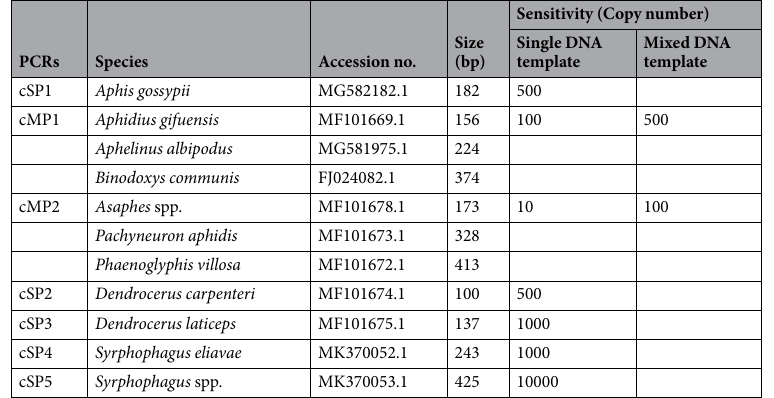
Table 1. GenBank accession, size and DNA detection limits for the amplification of cotton aphid and parasitoid species.